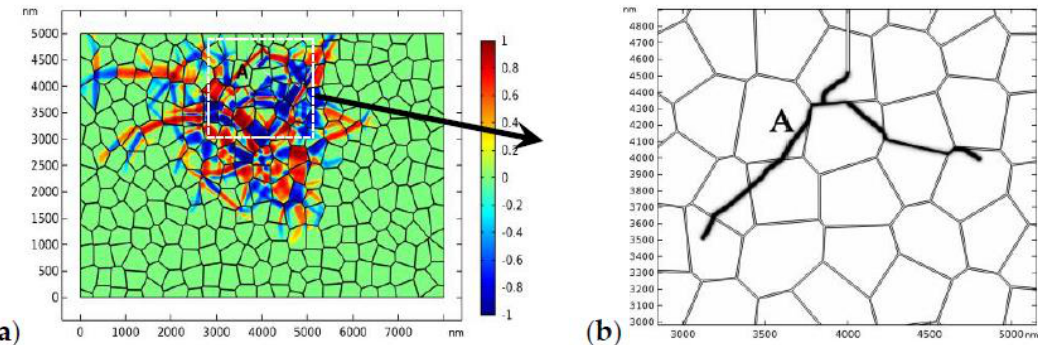
Figure 15. The evolution of the phase transformation ( a ) and crack propagation ( b ) in TZP (crystal orientation I) with a “weak” GB where the fracture toughness of the bulk grains is 1.0 MPa m and the fracture toughness of the GB is 0.5 MPa m. The applied load is 170 MPa.